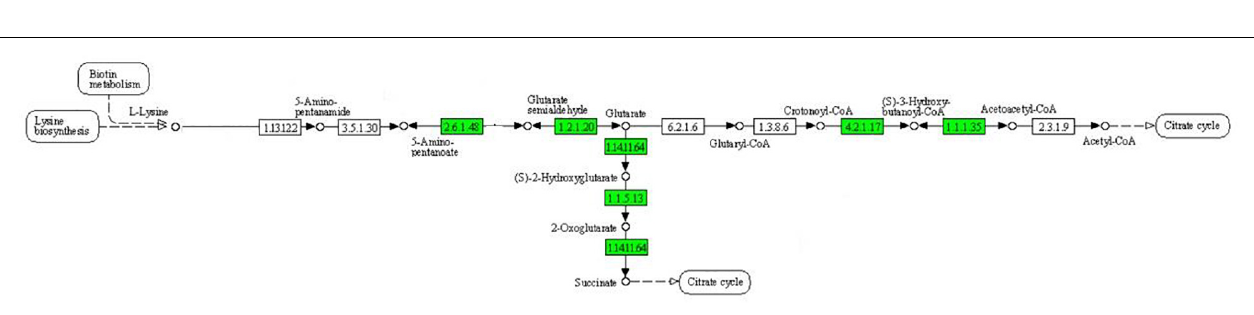
Frontiers in Microbiology |